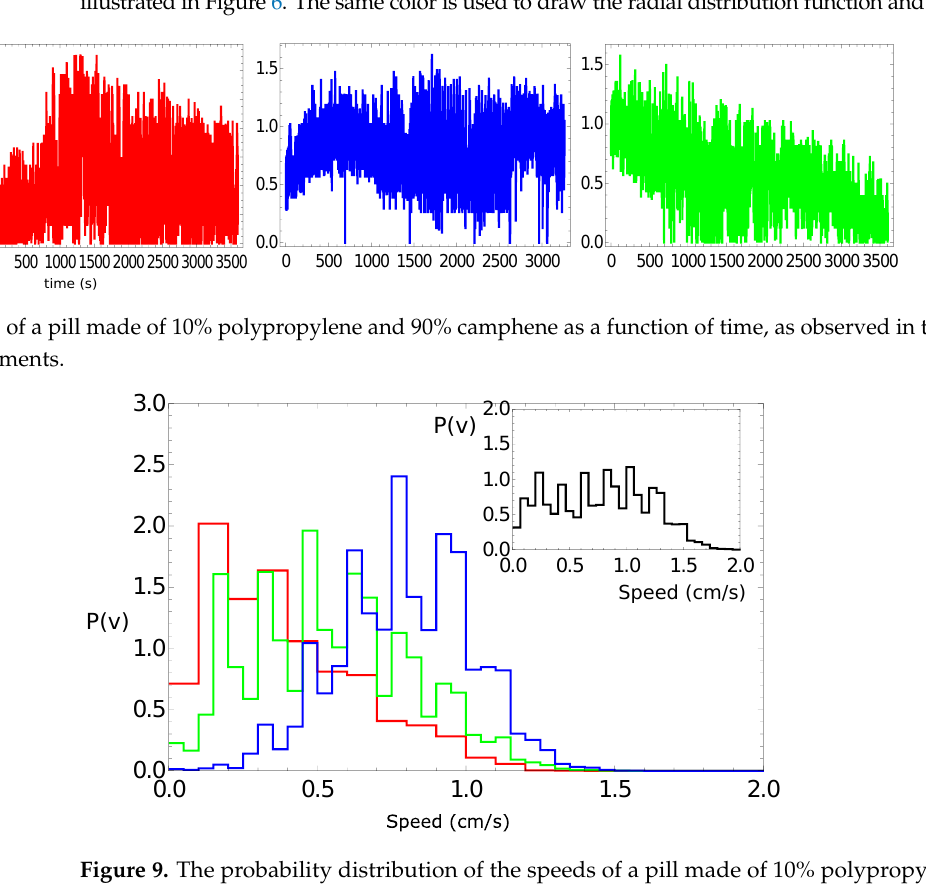
Figure 9. The probability distribution of the speeds of a pill made of 10% polypropylene and 90% camphene. The large figure shows the results of individual experiments. The distribution of the speed values observed in all experiments is shown in the